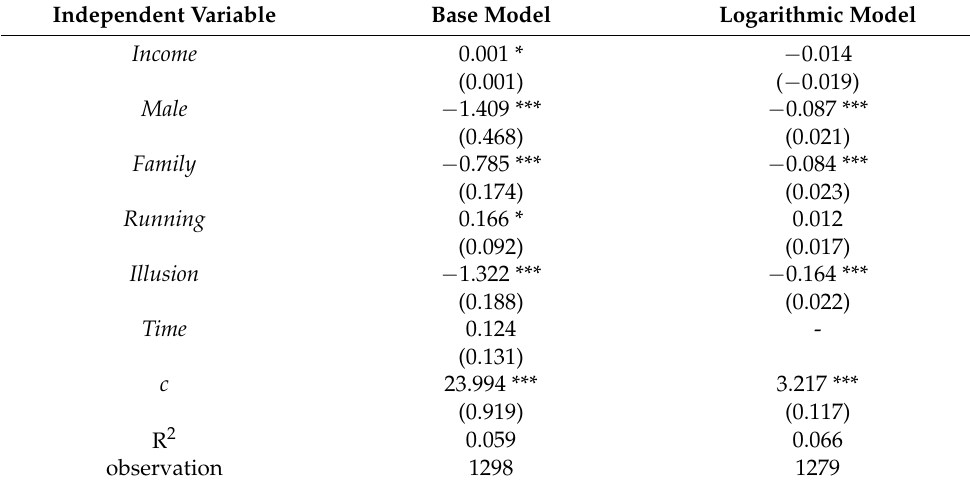
Table 6. Factor analysis of auto vehicle’s